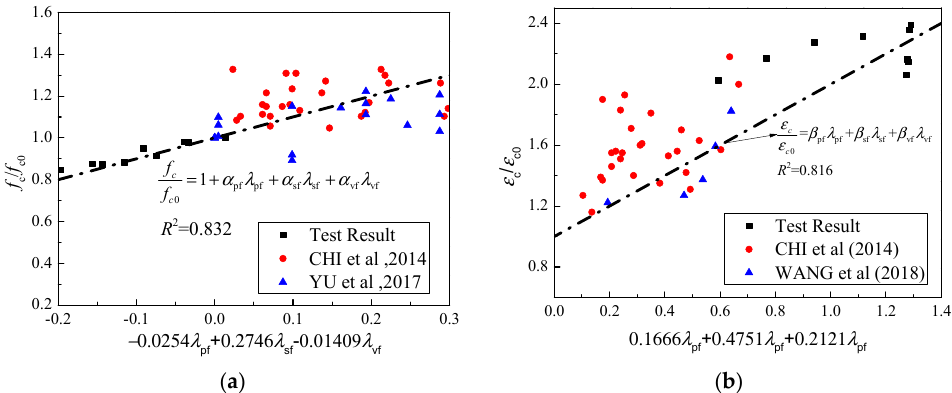
Figure 6. Comparison of peak and peak stress. ( a ) Comparison of peak stress. ( b ) Comparison of peak strain.